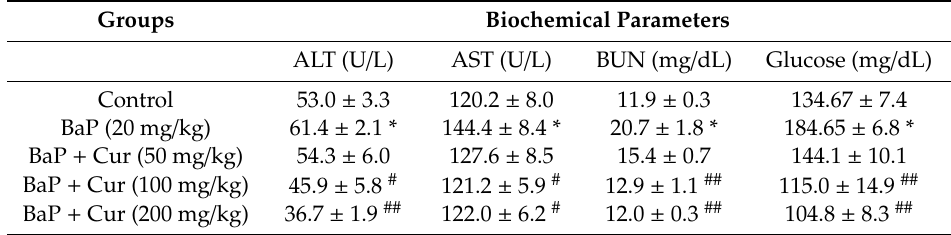
Table 2. Effects of Curcumin on Serum Biochemical Parameters in Sprague-Dawley Rats. Groups